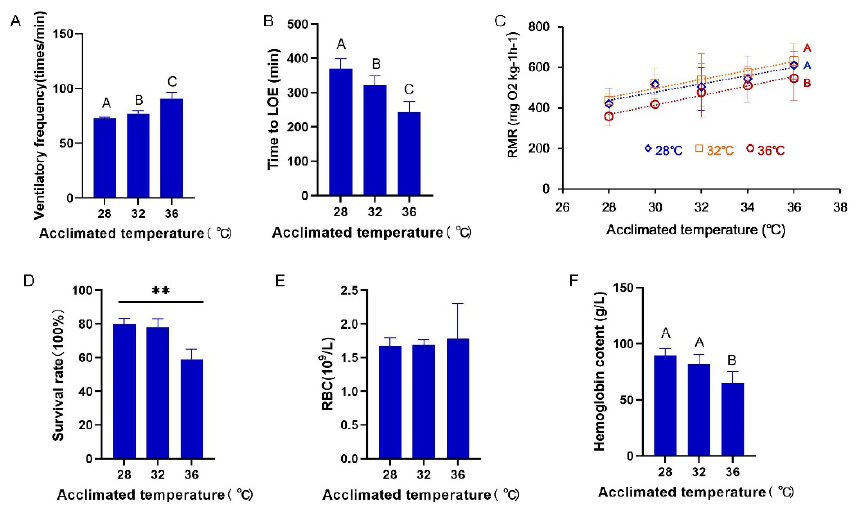
Figure 1. Phenotype statistics of GIFT tilapia exposed to 28, 32, and 36 °C for 15 weeks. ( A ) Ventilatory frequency ( n = 15). ( B ) Hypoxia tolerance (time to LOE at 0.2 mg/L O2; n = 15). ( C ) Routine metabolic rate (RMR; n = 15). ( D ) Survival rates (n = 90). ( E ) Red blood cell count ( n = 15). ( F ) Hemoglobin content ( n = 15). Presented are the means ± SEM. Statistical differences were compared by using nest ANOVA and mutiple comparisons of Tukey’s HSD; significances were illustrated by different capital letters ( p < 0.01) ( A , B , E , and F ). Fitting linear models were tested by covariance analyses ( p < 0.01) ( C ). A Chi -squared test was used to examine survival rates ( D ); ** indicates p < 0.01.